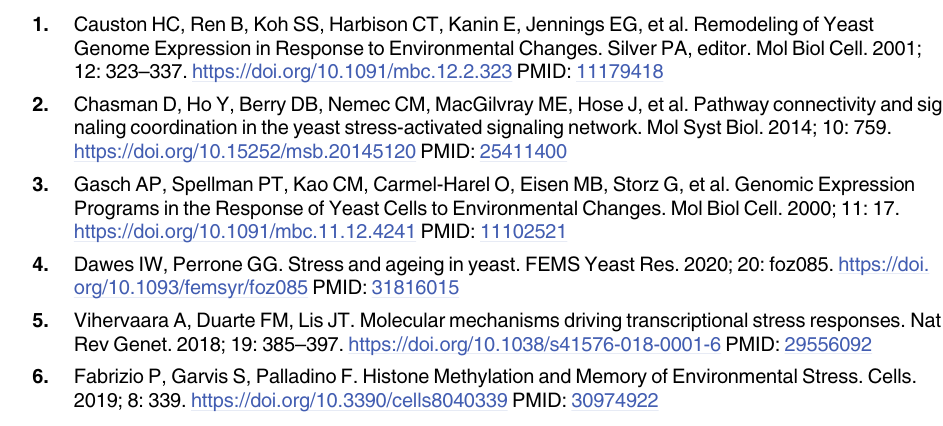
S11 Table. Yeast proteins organized by stress pathways, according to their range of disor- der ratio, determined with four disorder predictor programs and